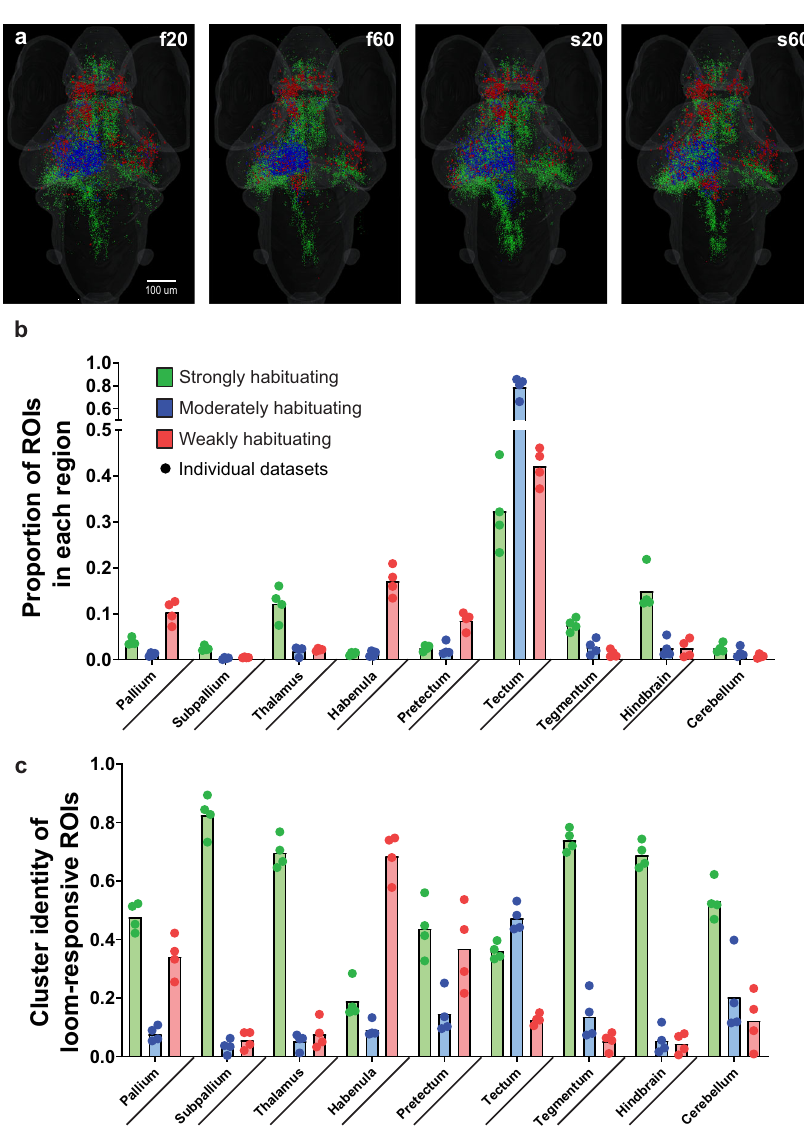
Fig. 3 Brain-wide responses during different loom stimulus trains. a Brain-wide distributions of the functional clusters from Fig. 2 for each of four loom habituation paradigms. b Averaged proportions of ROIs in the four data sets, from the brain ’ s total number of each functional cluster, located in the indicated brain regions. c Averaged proportion of each cluster ’ s representation among the loom-responsive ROIs in each brain region. The individual paradigms (f20, f60, s20, and s60) are represented as circles, n = 4 paradigms. Statistical analysis of these proportions is detailed in Supplementary Tables 1 and